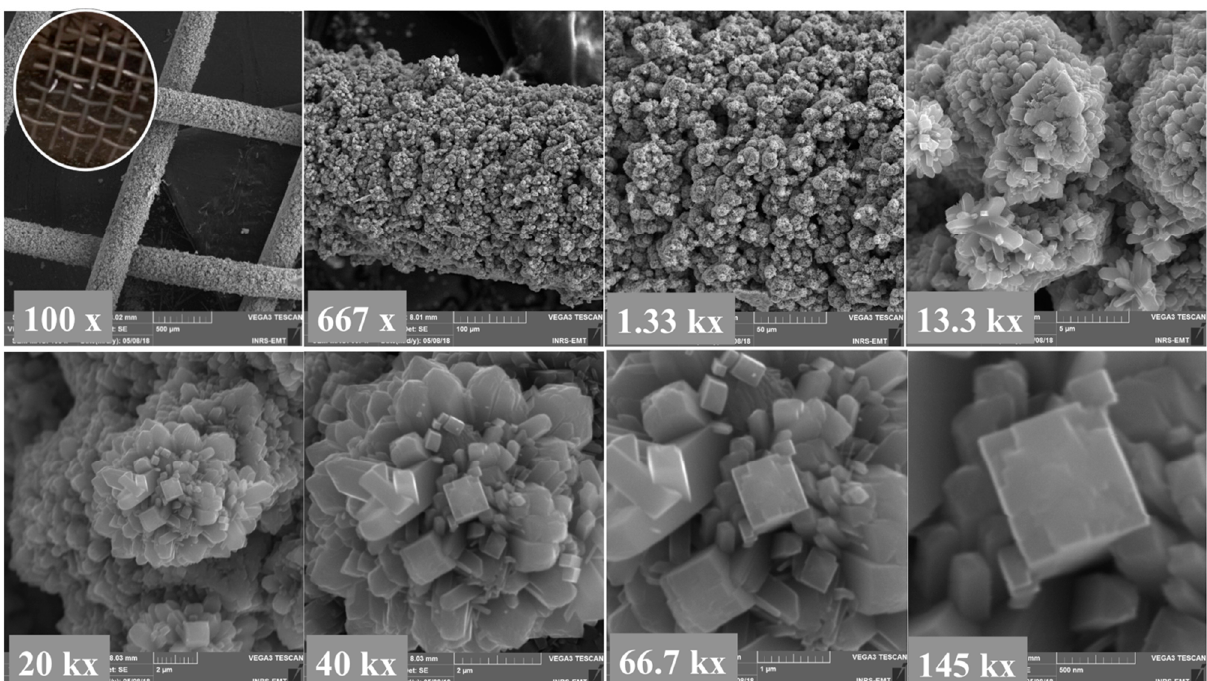
Figure 1. SEM images at different magnifications of hydrothermally-grown TiO 2 on Ti mesh. Inset at the top left figure is a photograph of TiO 2 /Ti mesh.